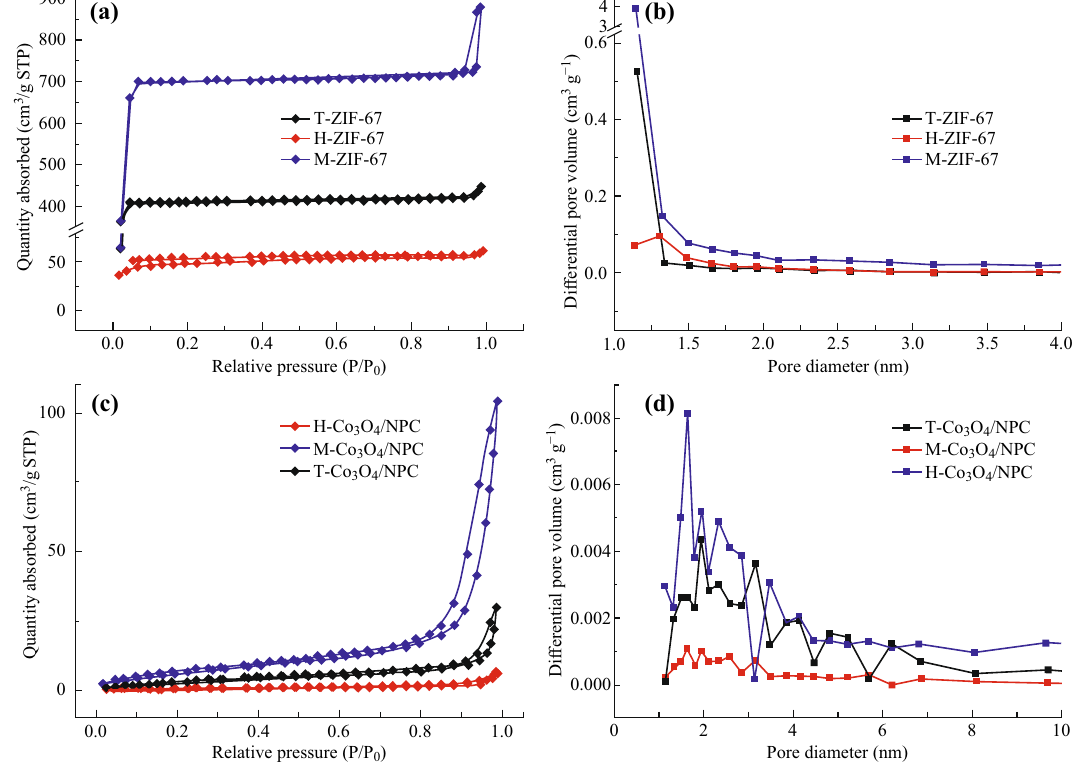
Fig. 5 a Nitrogen absorption–desorption isotherms and b pore size distributions of M-ZIF-67, H-ZIF-67, and T-ZIF-67. c Nitrogen absorption– desorption isotherms and d pore size distributions of T-Co 3 O 4 /NPC, M-Co 3 O 4 /NPC, and H-Co 3 O 4 /NPC